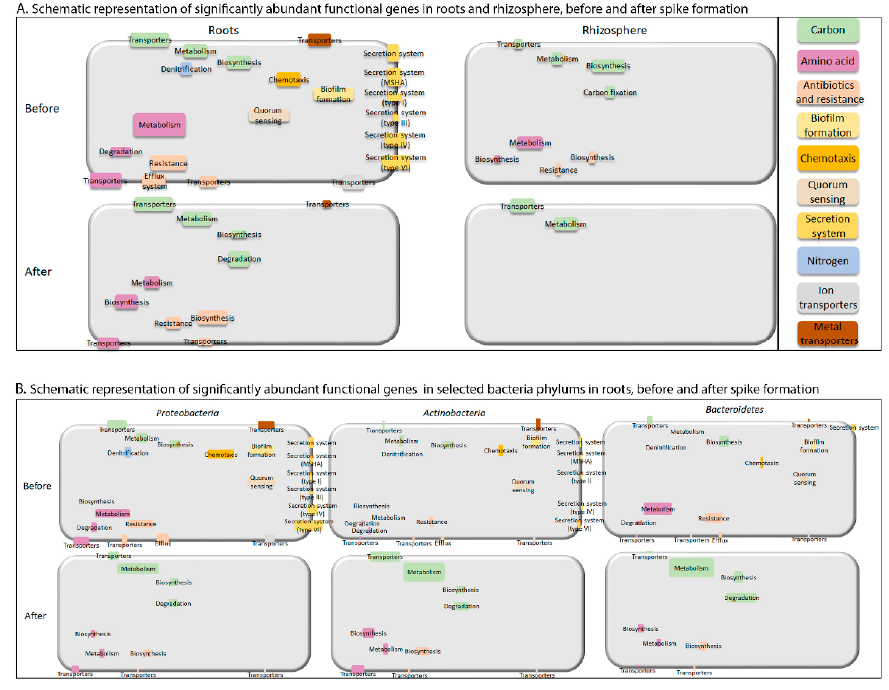
Figure 7. Schematic model presenting significantly abundant functional genes. ( A ) Schematic representation of significantly abundant functional genes before and after spike formation in roots and rhizosphere. Size of each rectangle is proportional to sum of significantly enriched functional gene counts in each subcategory, calculated based on data in Figure 6B,C. ( B ) Schematic representation of significantly abundant functional genes before and after spike formation in roots in the three selected, dominant bacterial phyla proteobacteria , Actinobacteria and Bacteroidetes . Size of each rectangle is proportional to normalized amount of the gene functions (using normalized count transformation in DESeq2 package), divided by relative abundance of each relevant taxa. List of all normalized counts is provided in Supplemental Table